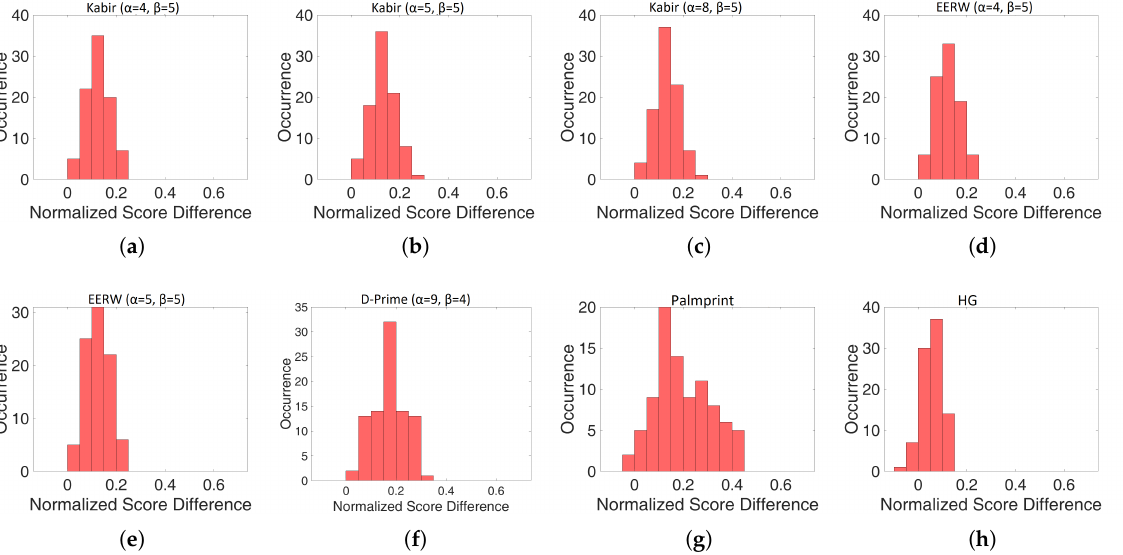
Figure 7. Distribution of Normalized Score Difference (NSD) between the highest impostor score and the lowest genuine score for: ( a ) Kabir ( α = 4, β = 5), ( b ) Kabir ( α = 5, β = 5), ( c ) Kabir ( α = 8, β = 5), ( d ) EERW ( α = 4, β = 5), ( e ) EERW ( α = 5, β = 5), ( f ) D-Prime ( α = 9, β = 4), ( g ) Palmprint, ( h ) HG.